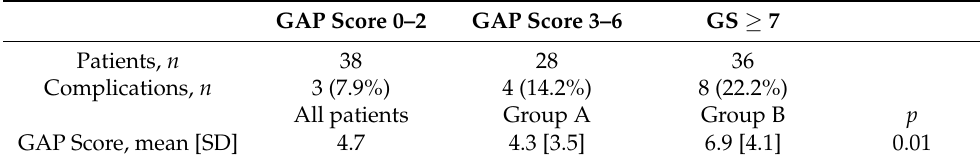
Table 5. Global Alignment and Proportion (GAP) score distribution.